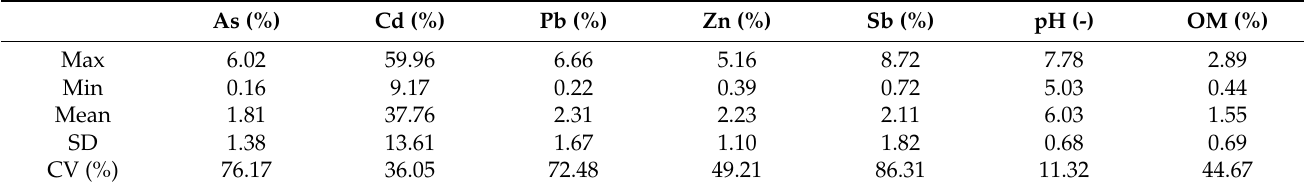
Table 4. The bioavailable fractions of the heavy metals and metalloids in